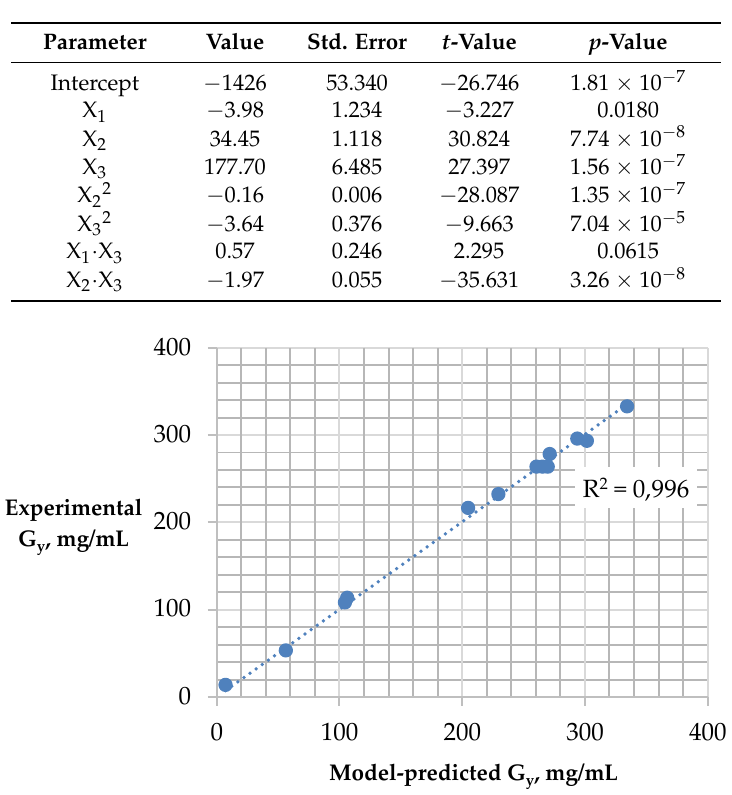
Table 4. Model parameters for Box-Behnken design for alkaline pre-treatment and acid hydrolysis of Triticum sp.